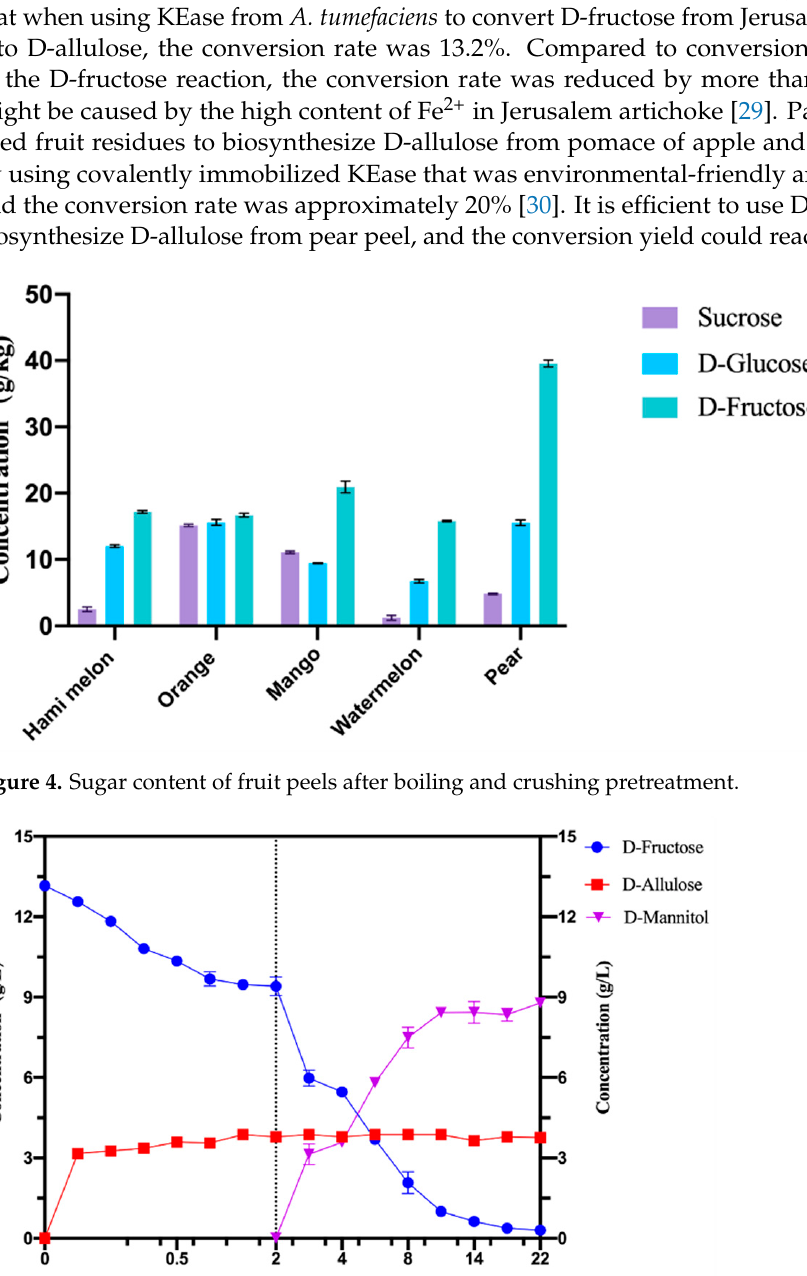
Figure 4. Sugar content of fruit peels after boiling and crushing pretreatment.